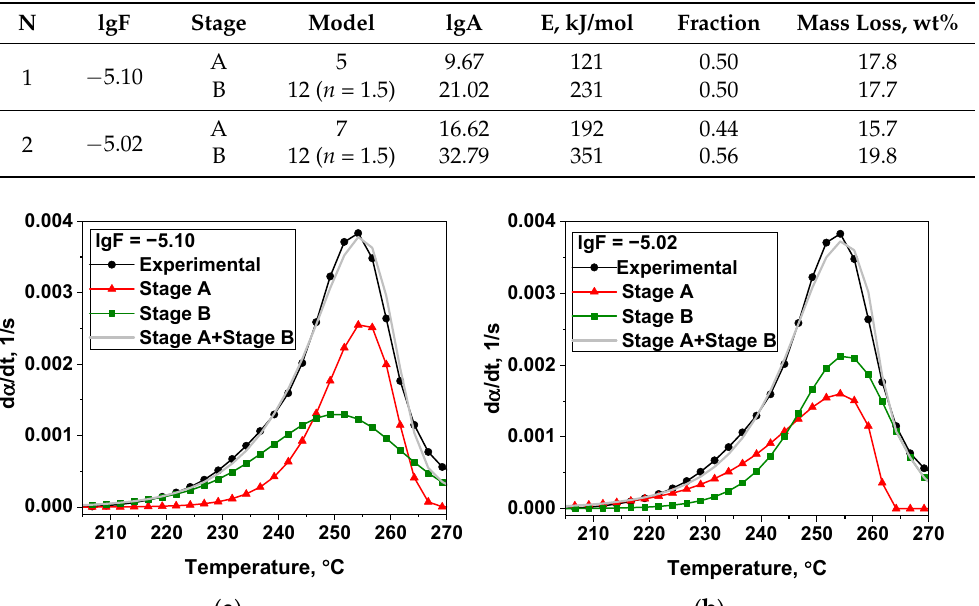
Table 4. Two chosen results for the modeling of the main peak of the DTG curve (region I) during the